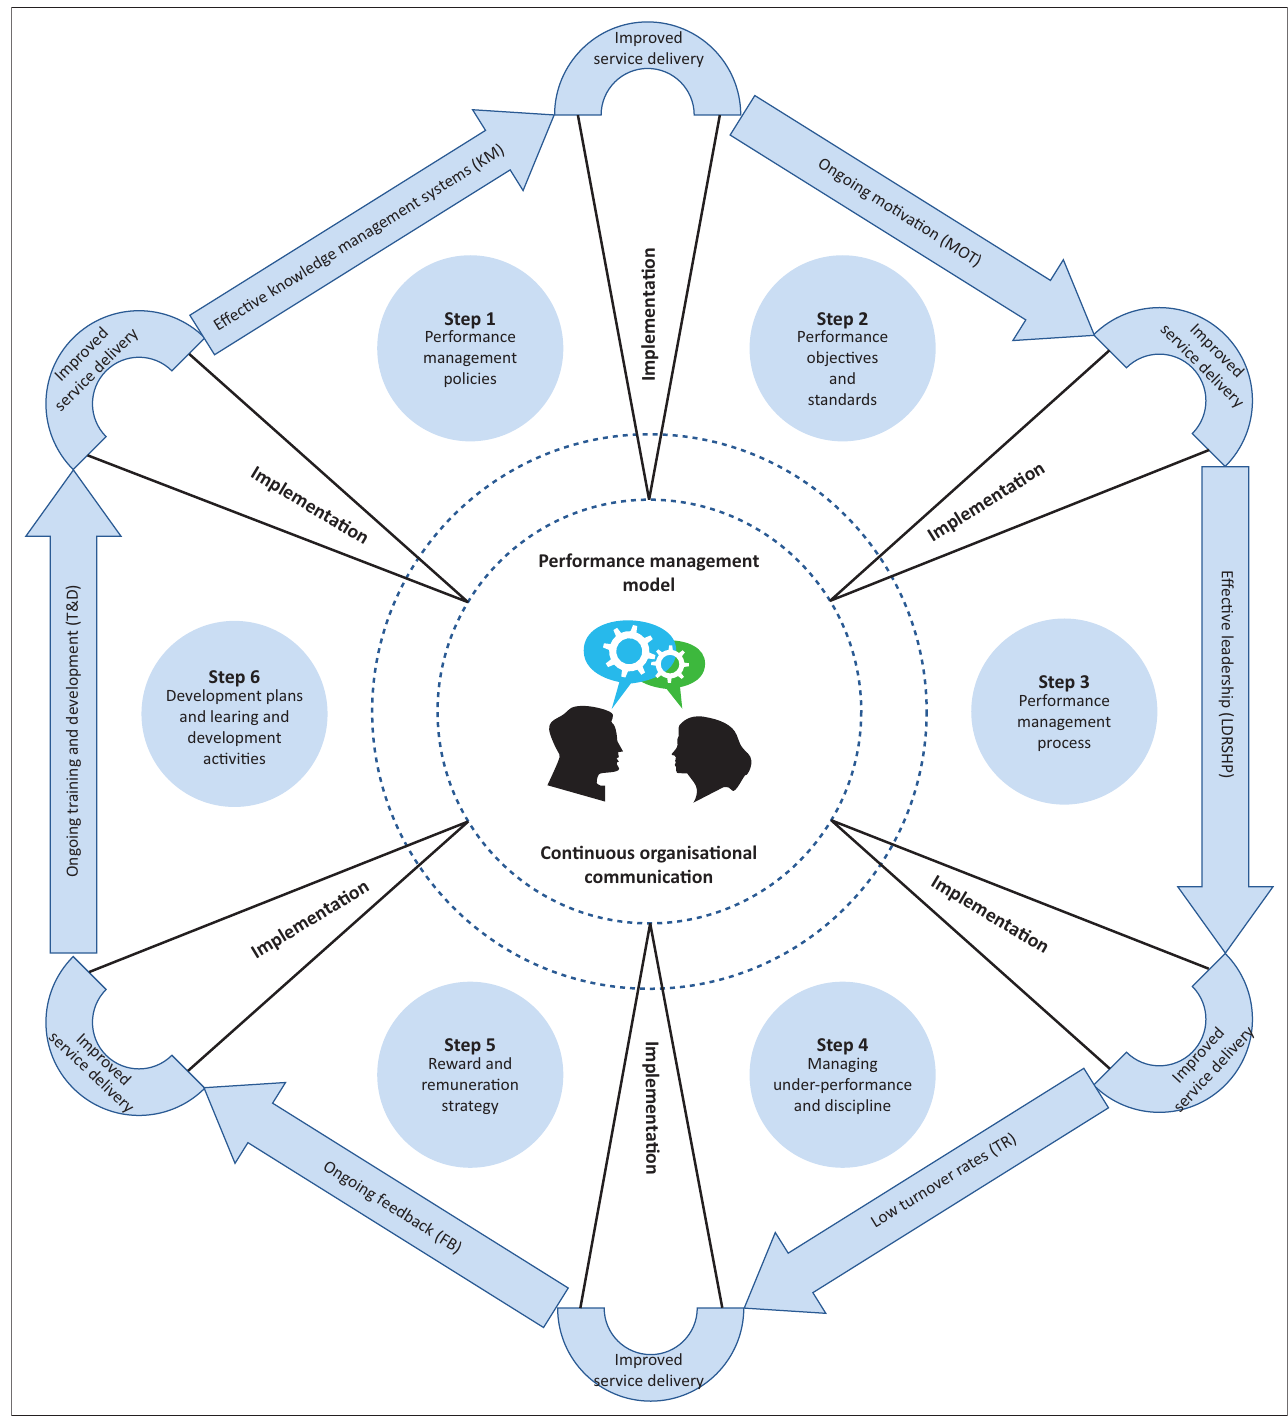
FIGURE 10: Performance management